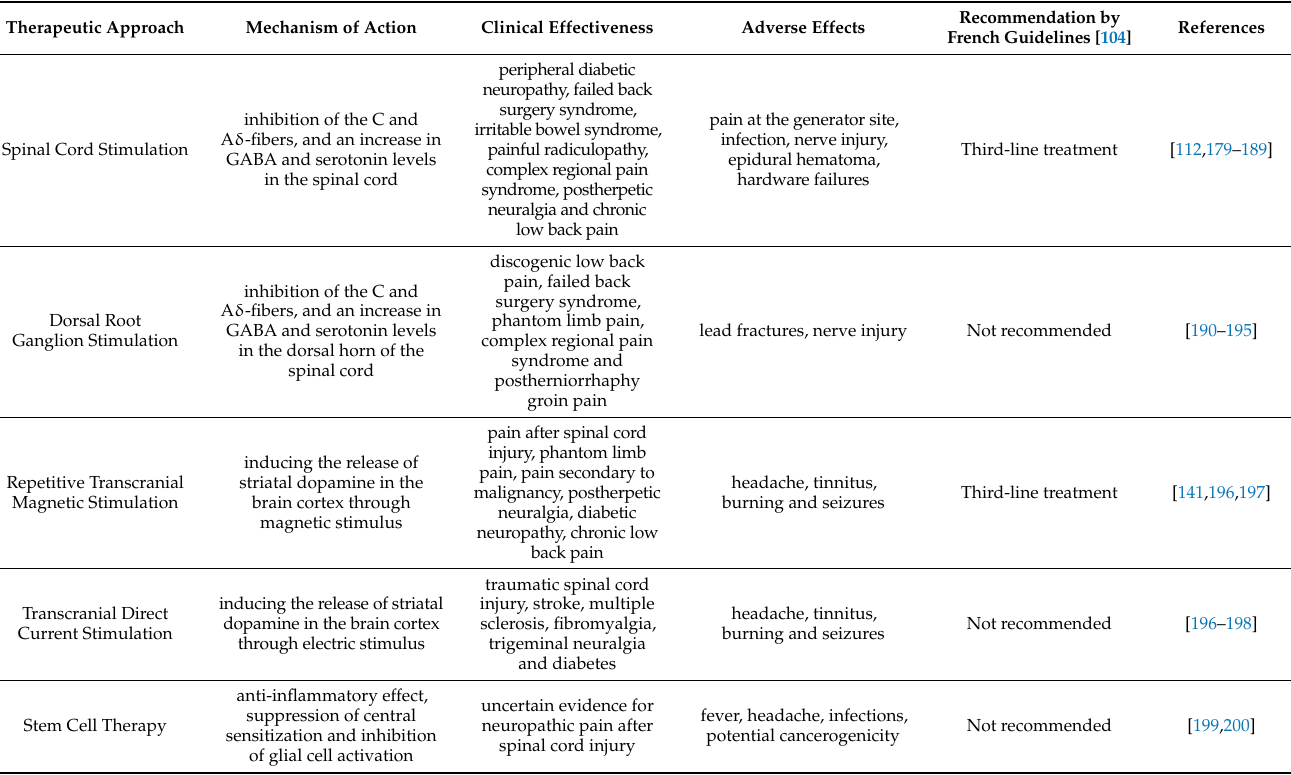
Table 3. A summary of currently available non-pharmacological therapeutic methods for neuropathic